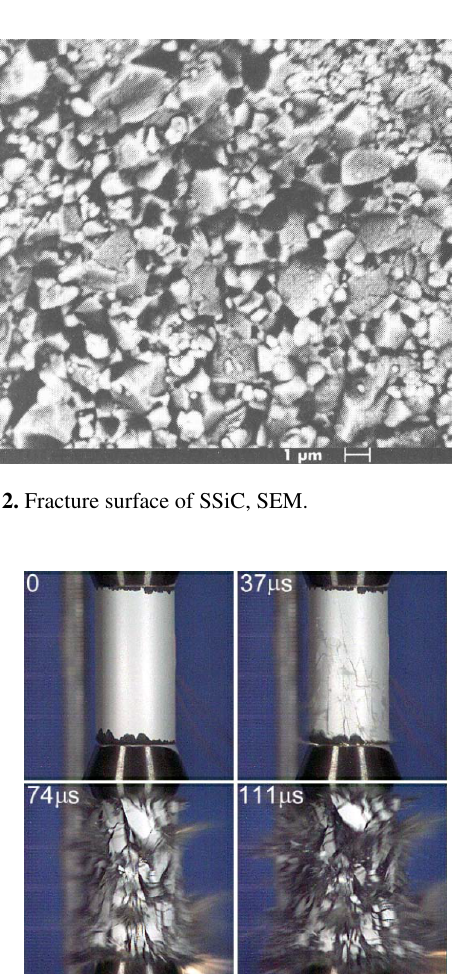
ple stress distribution. The tensile stress generated along in- ner surface of most upper part of the cylinder never exceeds 150 MPa. The cylinder fails abruptly according to Fig.